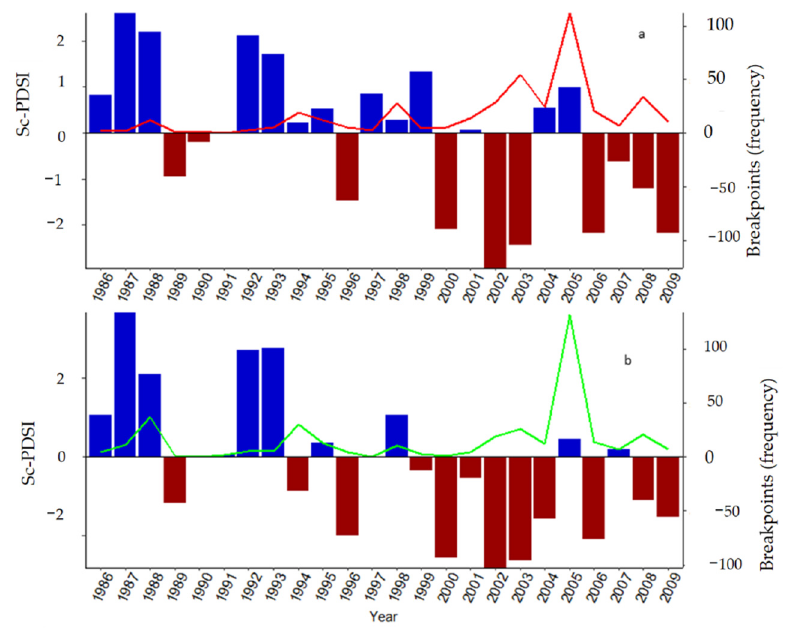
Figure 10. A summary of breakpoints with ( a ) decreasing and ( b ) increasing trends in productivity along with the weighted average of self-calibrated Palmer Severity Drought Index (sc-PSDI).